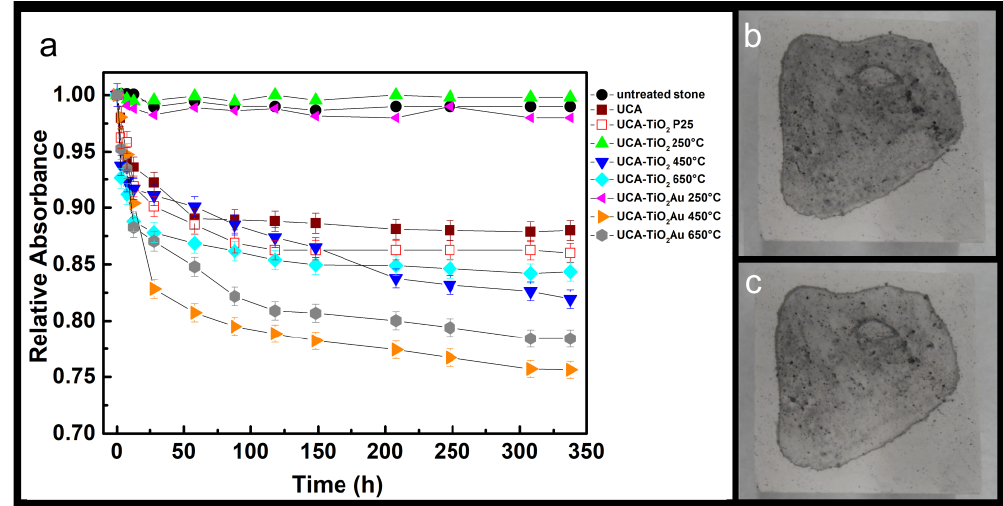
Figure 7. ( a ) Photocatalytic soot oxidation of each material under study reported in terms of relative absorbance A / A 0 vs. time. Each data point is the mean of three replicates. Soot degradation on the stone treated with UCA–TiO 2 Au 450 °C obtained at different irradiation times: ( b ) 0 min and ( c ) 340 h.